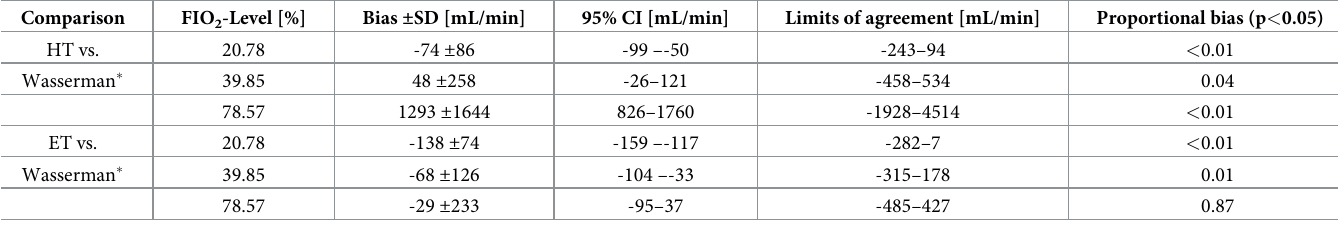
Table 4. Bland-Altman limit analysis for comparison between HT and ET for _ VO